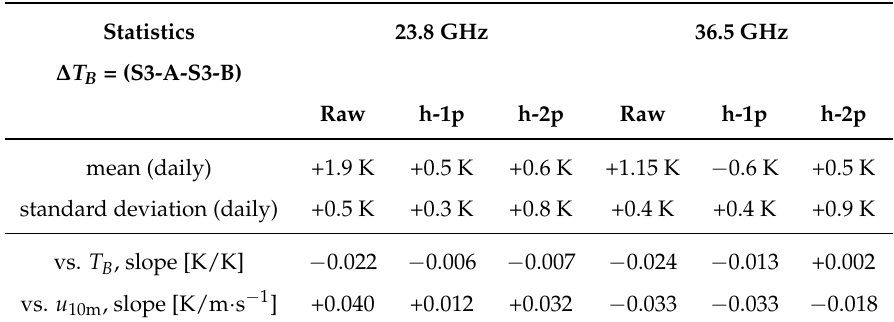
Table 3. Characterization of the difference between S3-A and S3-B T B for both channels and for the baseline, h-1p and h-2p T B